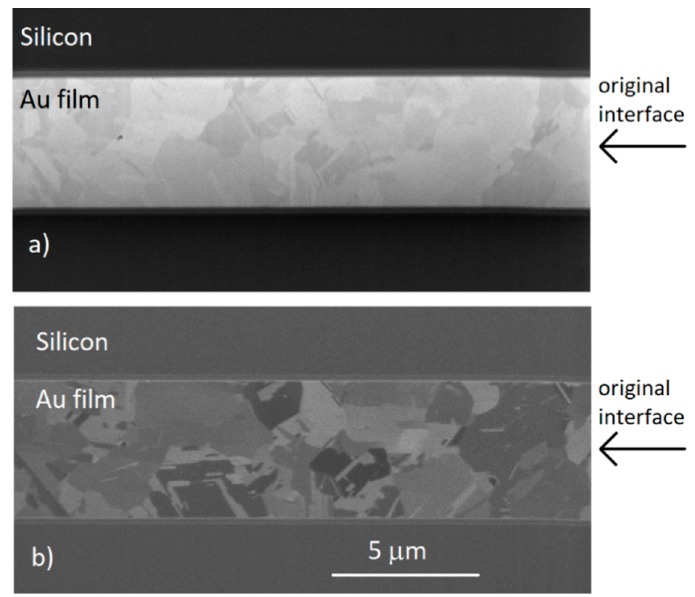
Figure 6. Cross-sectional ( a ) electron beam and ( b ) ion beam images of bonded 4 µ m samples.